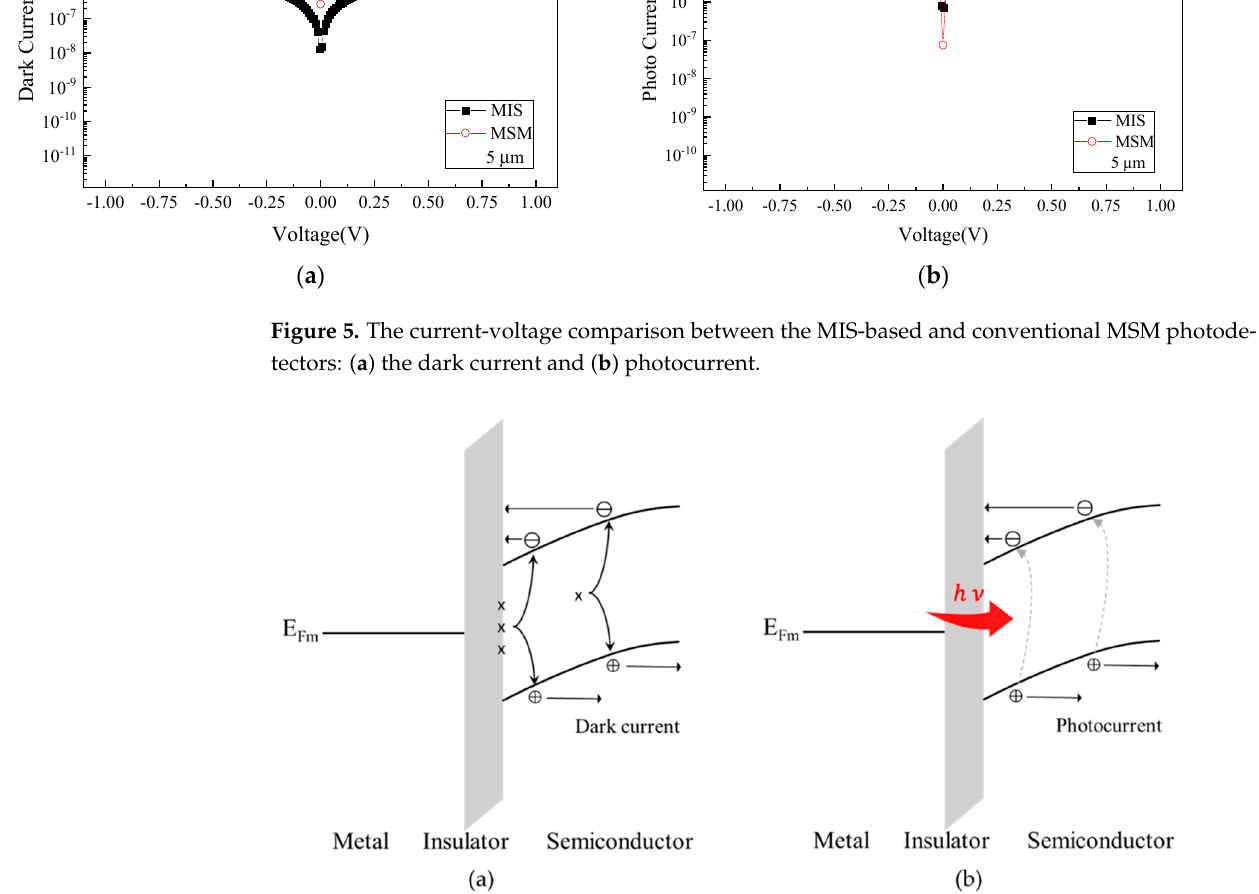
Figure 6. Band diagrams of an MIS diode: ( a ) in a dark condition and ( b ) under light illumination. The entire measurement setup consists of a probe station, an IR light source for wave- lengths up to 2100 nm, a source meter, and data acquisition software. Specifically, the current-voltage measurement data of our photodetectors are collected with a Keithley 2632 A source meter. The light source used to deliver light of different wavelengths